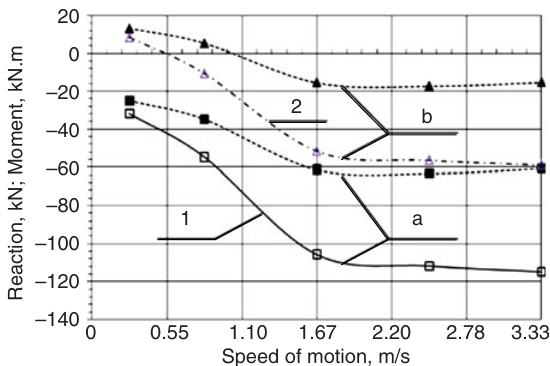
Fig. 5. Changes in the loading of the semi-frame’s hinge joint while moving through roughness of 0.25 m: a – a wheel of energetic module; b – a wheel of engineering module; 1 – bending moment; 2 – torsion